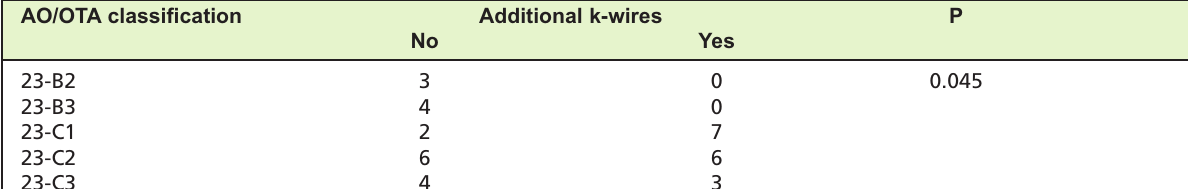
Correlation between AO/OTA classification and additional K-wires (Pearson Correlation Test) Table V: